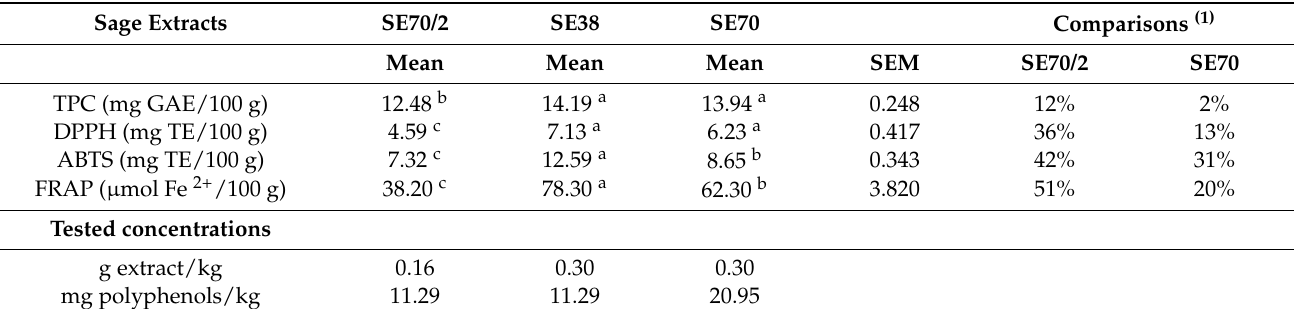
Table 2. Antioxidant capacity of sage extracts (SE70/2, SE70, and SE38) determined at the same concentrations used for 100 g of yoghurt